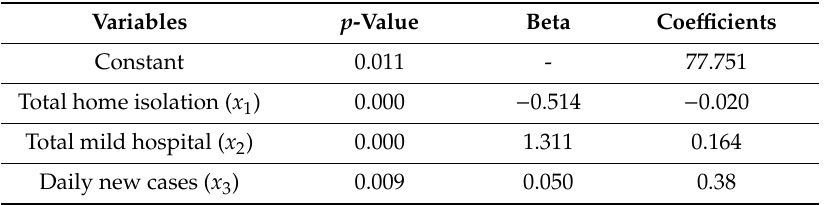
Table 11. The results of the MLR